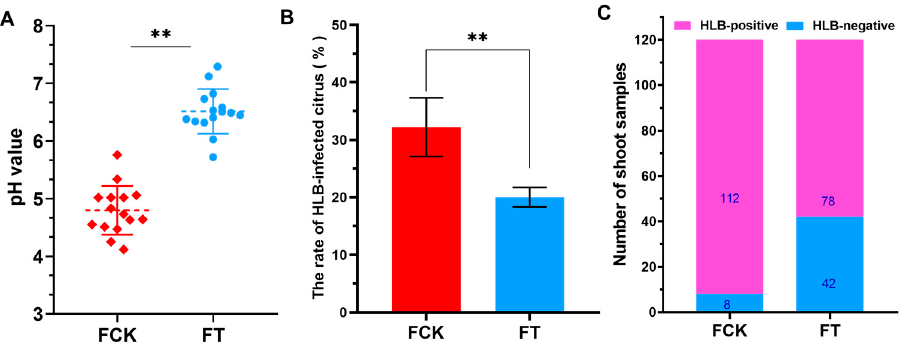
Figure 1. E ff ect of acid soil improvement on the spread and movement of Huanglongbing (HLB) disease in the field trial. ( A ) Soil pH value in citrus orchards. The blue dots represent the soil pH before treatment, and the red dots represent the soil pH at the fifth month after treatment. FCK, control grove in the field trial; FT, treatment grove in field trial. ( B ) The new infections rate of HLB disease in FCK and FT at the fifth month after soil treatment. Data represent the mean ± SD of three independent biological replicates. Asterisks indicate a significant di ff erence according to the Student’s t -test: ** p < 0.01. ( C ) Detection of CLas bacterium in the leaves of new asymptomatic shoots of HLB-infected citrus trees in FCK and FT.